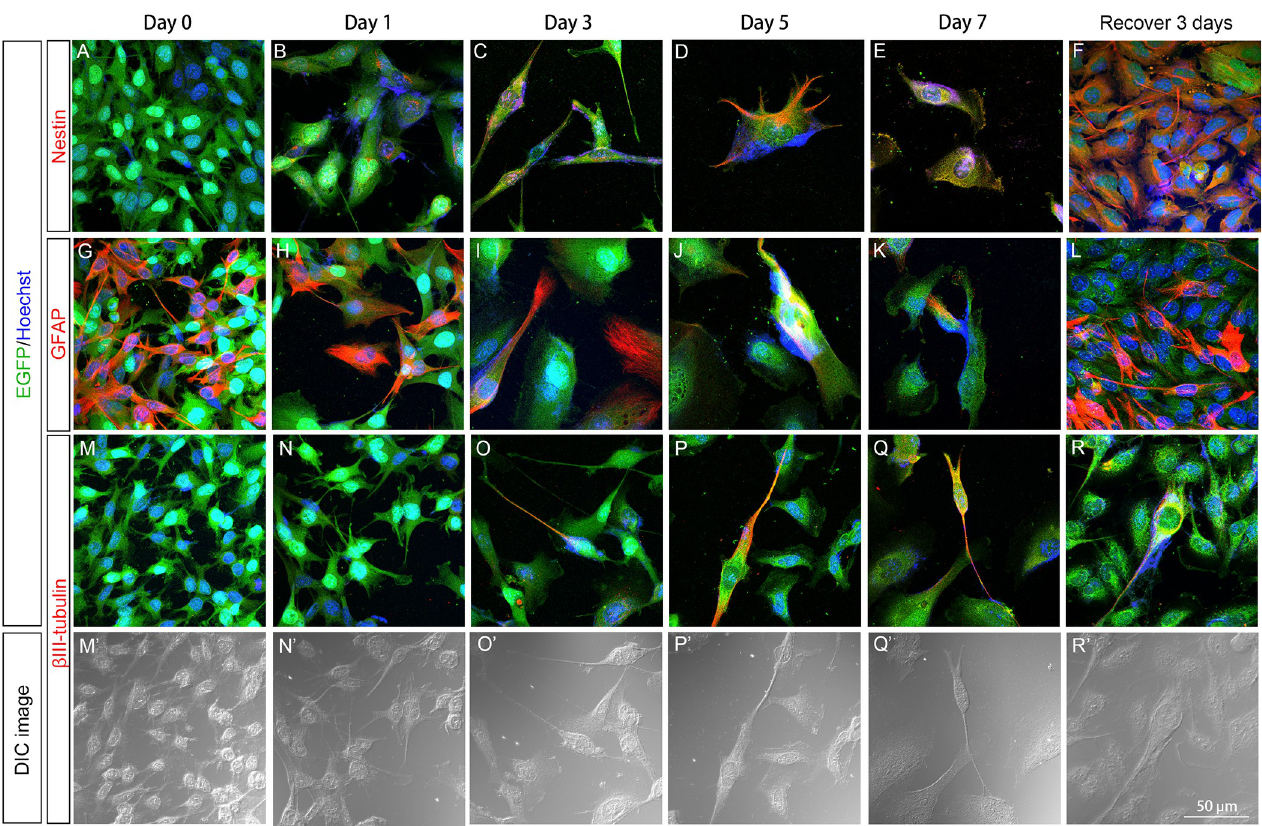
Fig 4. Patterns of nestin, GFAP, and β III-tubulin expression in U251-pGFAP-HSVtk cells. U251-pGFAP-HSVtk cells were treated with 5 μ g/ml GCV for 7 days, and then GCV was withdrawn to allow cell recovery for 3 days. Immunocytochemistry of nestin (A–F), GFAP (G–L), and β III-tubulin (M–R, M 0 –R 0 ) were performed to characterize the identity of surviving cells. The expression level of nestin was increased during 7 days of GCV treatment (A–E) and strong expression of nestin was detected after recovery (F). (D–F) Filamentous expression of nestin was detected at day 5, day 7, and after recovery. (H–K) U251-pGFAP-HSVtk cells with strong GFAP expression at day 0 (G) were gradually ablated during 7 days of GCV treatment. (L) After GCV was withdrawn for 3 days, some cells expressed a high level of GFAP. (G–L) Filamentous GFAP could be found in cell processes and cell bodies. β III-tubulin could not be detected at day 0 and day 1 (M, N), and was observed weakly at day 3 of GCV treatment (O). (P–R) β III-tubulin-positive cells were identified after 5 days of GCV treatment and recovery for 3 days. (M 0 –R 0 ) In DIC images, β III-tubulin-positive cells displayed elongated processes, rounded nuclei, and bulging cell bodies, while β III-tubulin-negative cells were smooth. Scale bar, 50 μ